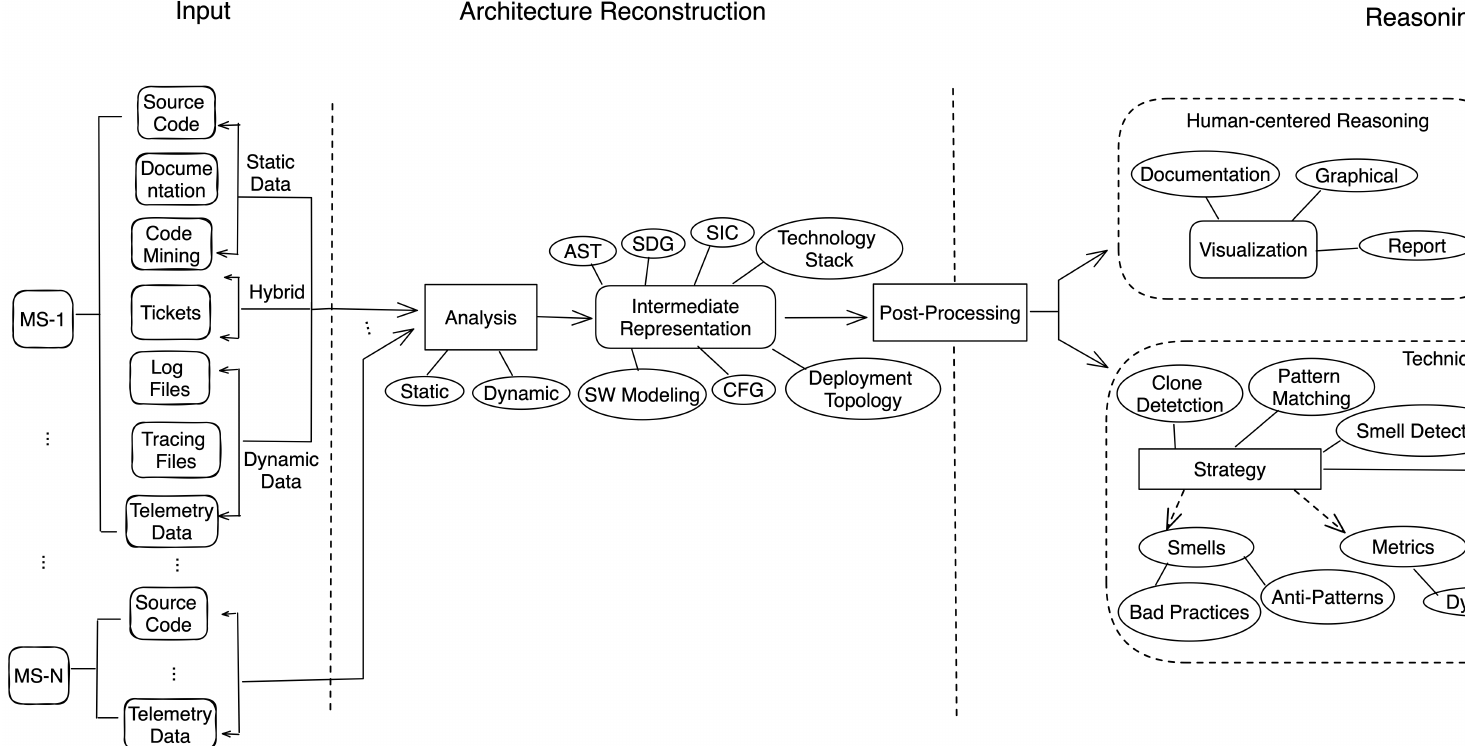
Figure 2. Microservices reasoning